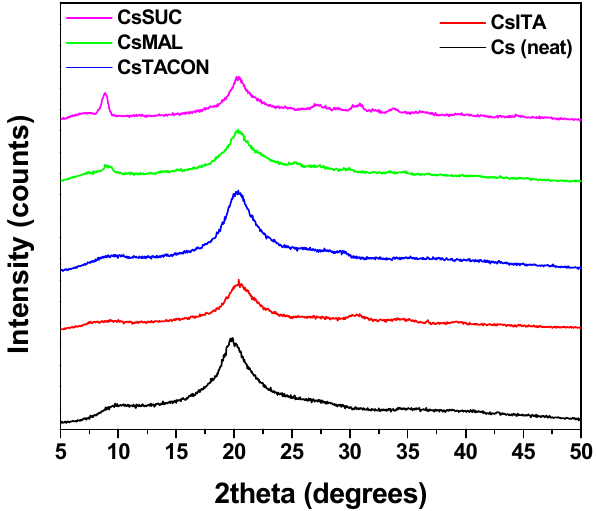
Figure 3. XRD patterns of the synthesized uncross-linked materials.